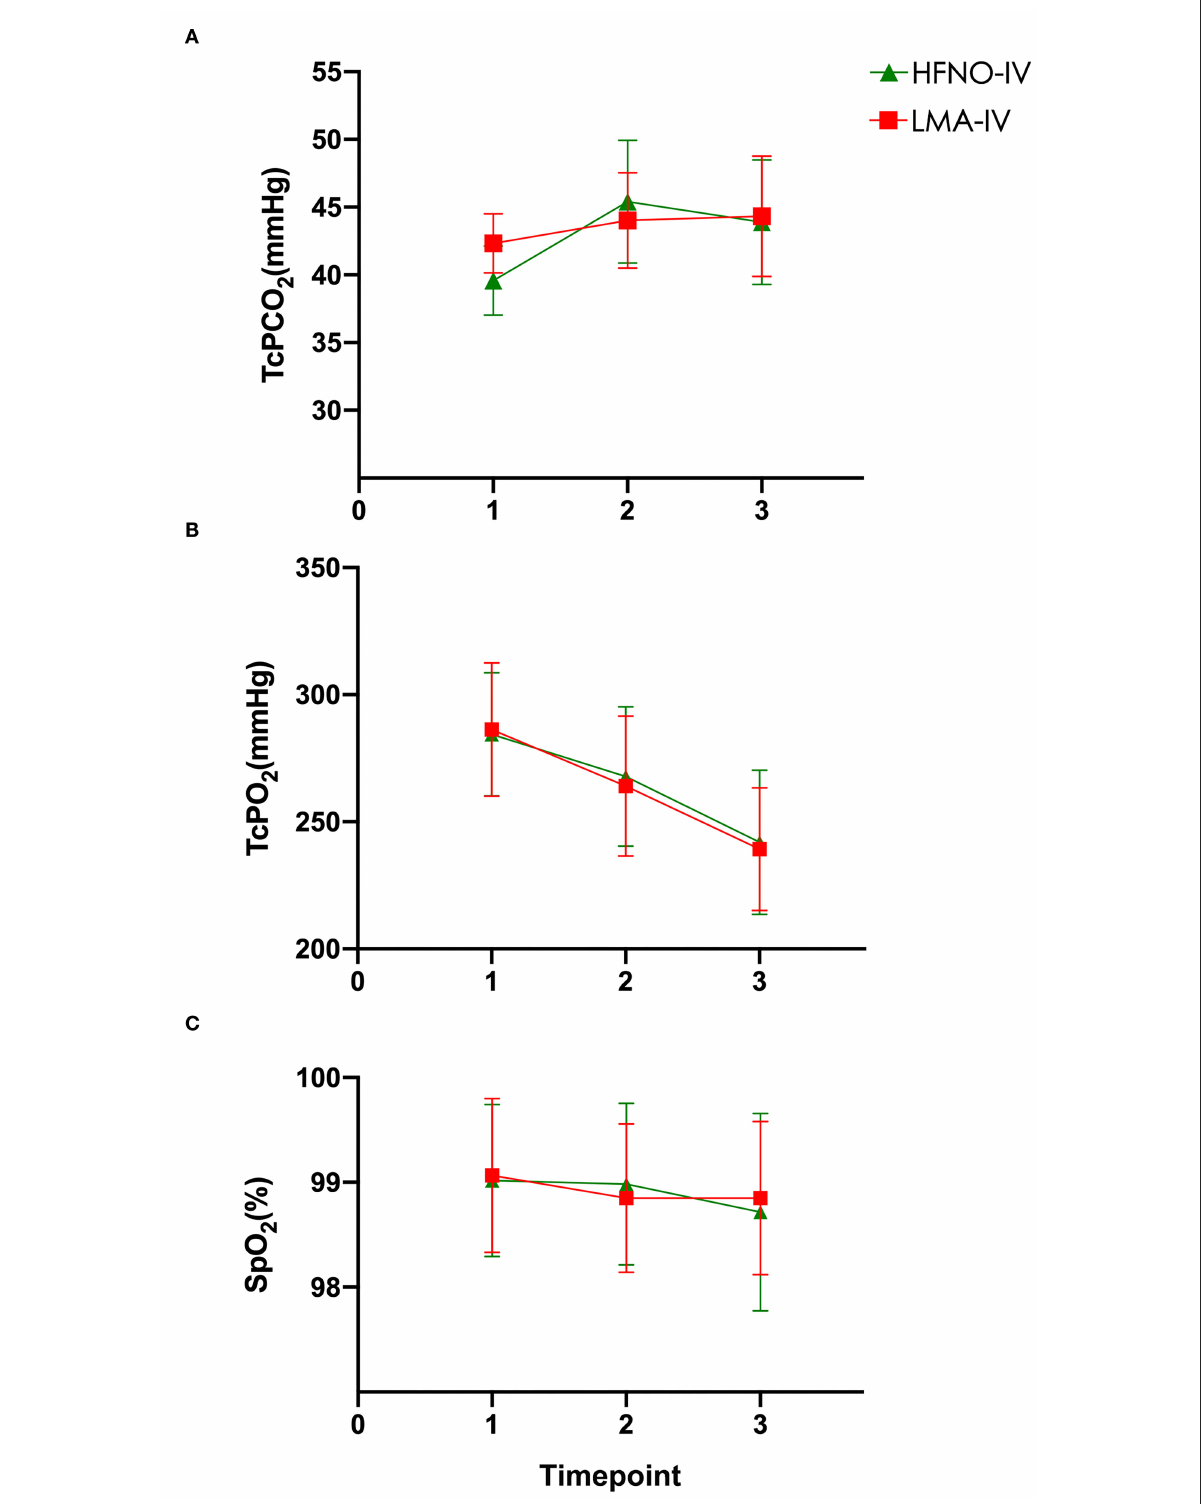
FIGURE2 (A–C) Carbon dioxide, oxygen, and SpO 2 levels were measured at baseline, at the beginning of the operation, and at the end of the